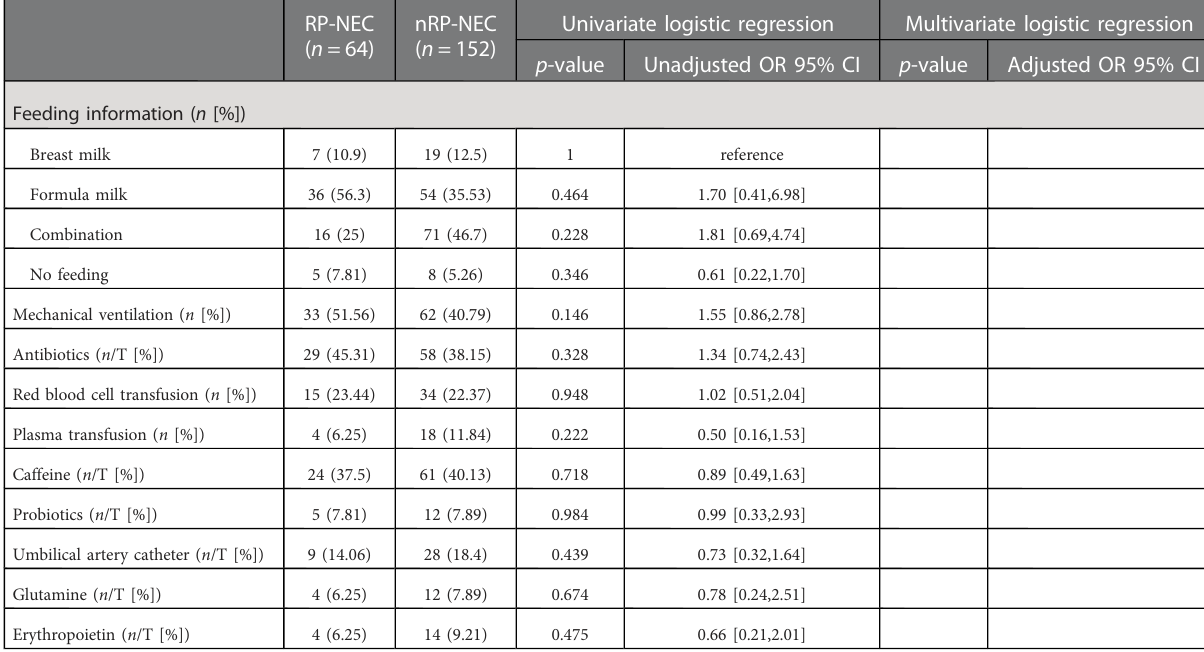
TABLE 2 Univariate and multivariate logistic regression analyses for postnatal administrations of RP- and